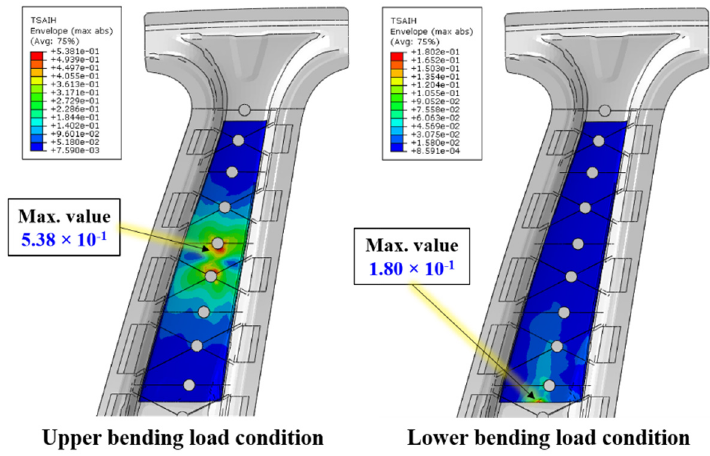
Figure 18. Tsai–Hill criterion contour results of CFRTP patch.